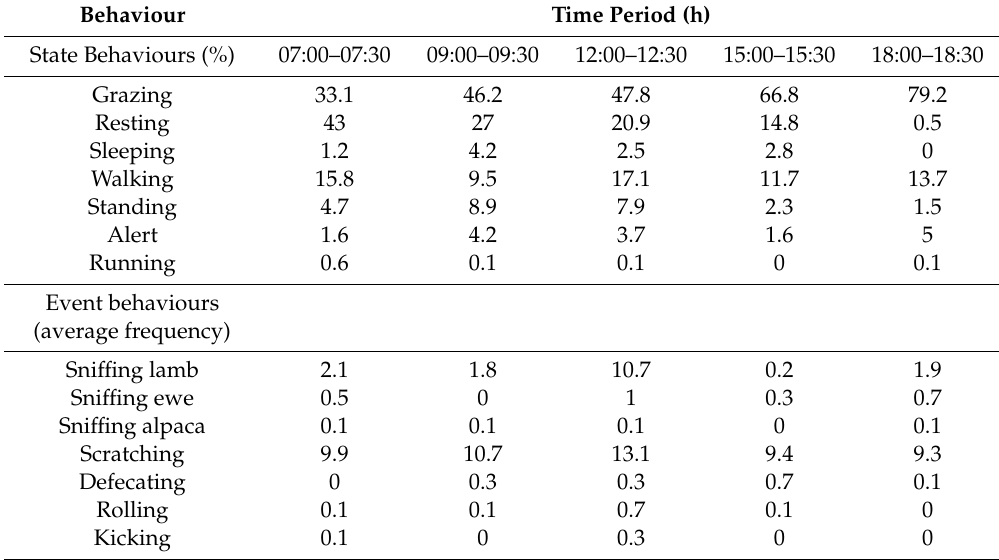
Table 3. Average time spent on state behaviours (%) and average frequency (number) of event behaviours by alpacas ( n = 2) during the 5 di ff erent time periods (hours) across the 10 observation days. ‘Drinking’ behaviour was excluded due to low occurrence. Each time period represents 30-min of behavioural observation (shown here as a percentage of time spent performing behaviour within the 30-min window). Refer to Methods Section 2.3 for definition of